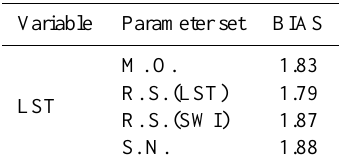
Table 11. The Casentino basin. Values of BIAS on LST series ob- tained with the different parameter sets. The mean basin scale has been considered.